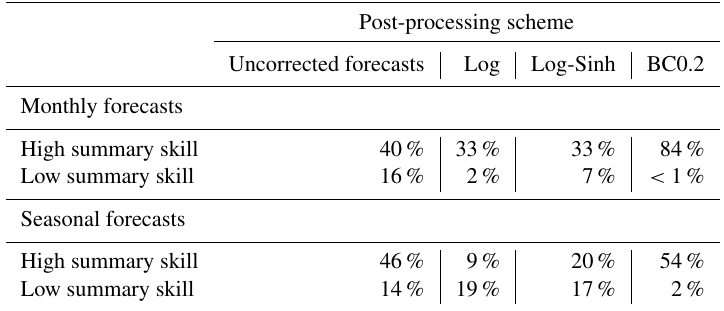
Table 1. Performance of post-processing schemes, expressed as the percentage of catchments with high and low summary skill. Results shown for monthly and seasonal forecasts. A catchment with “high summary skill” is defined as a catchment where “high-skill” forecasts are achieved in 10–12 months out of the year; “high-skill” forecasts are defined as forecasts that are reliable and sharper than